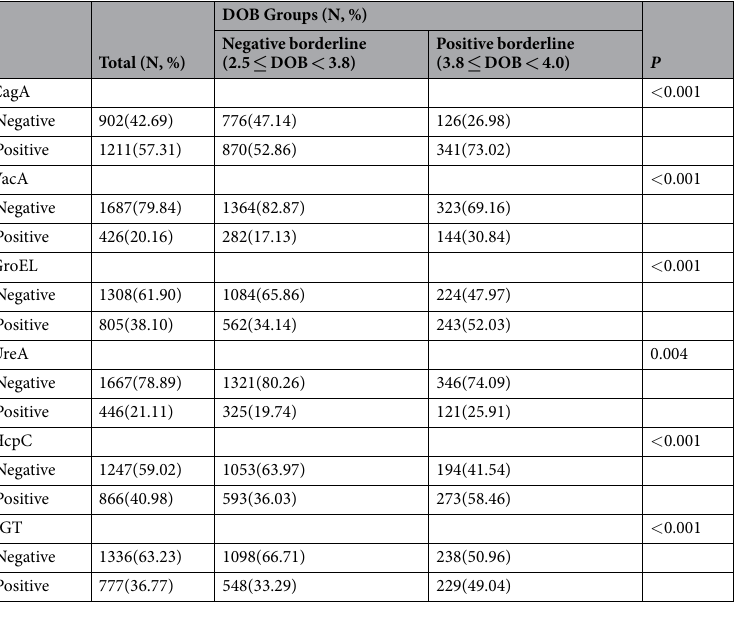
Table 5. Seropositivities for H.pylori specific antibodies in borderline subjects with different DOB value. DOB, Delta over baseline-value.